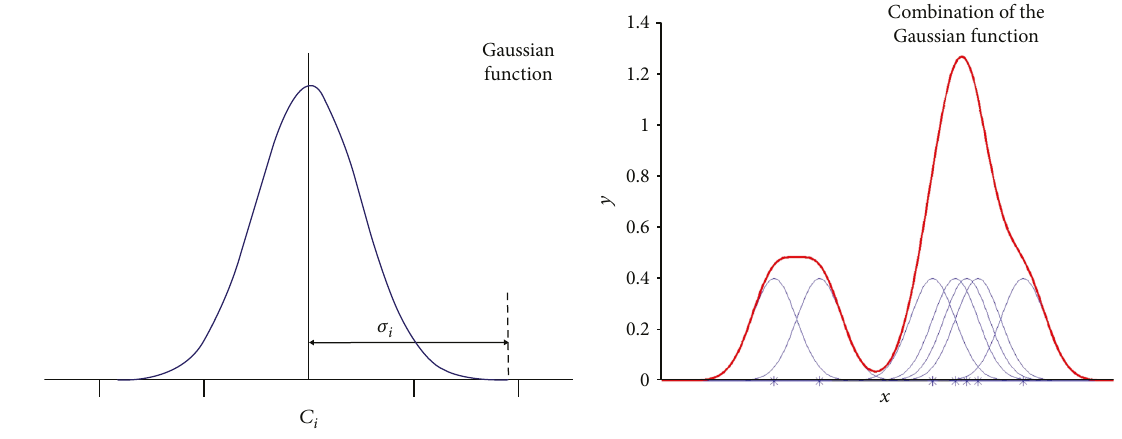
Figure 5: Gaussian function used as